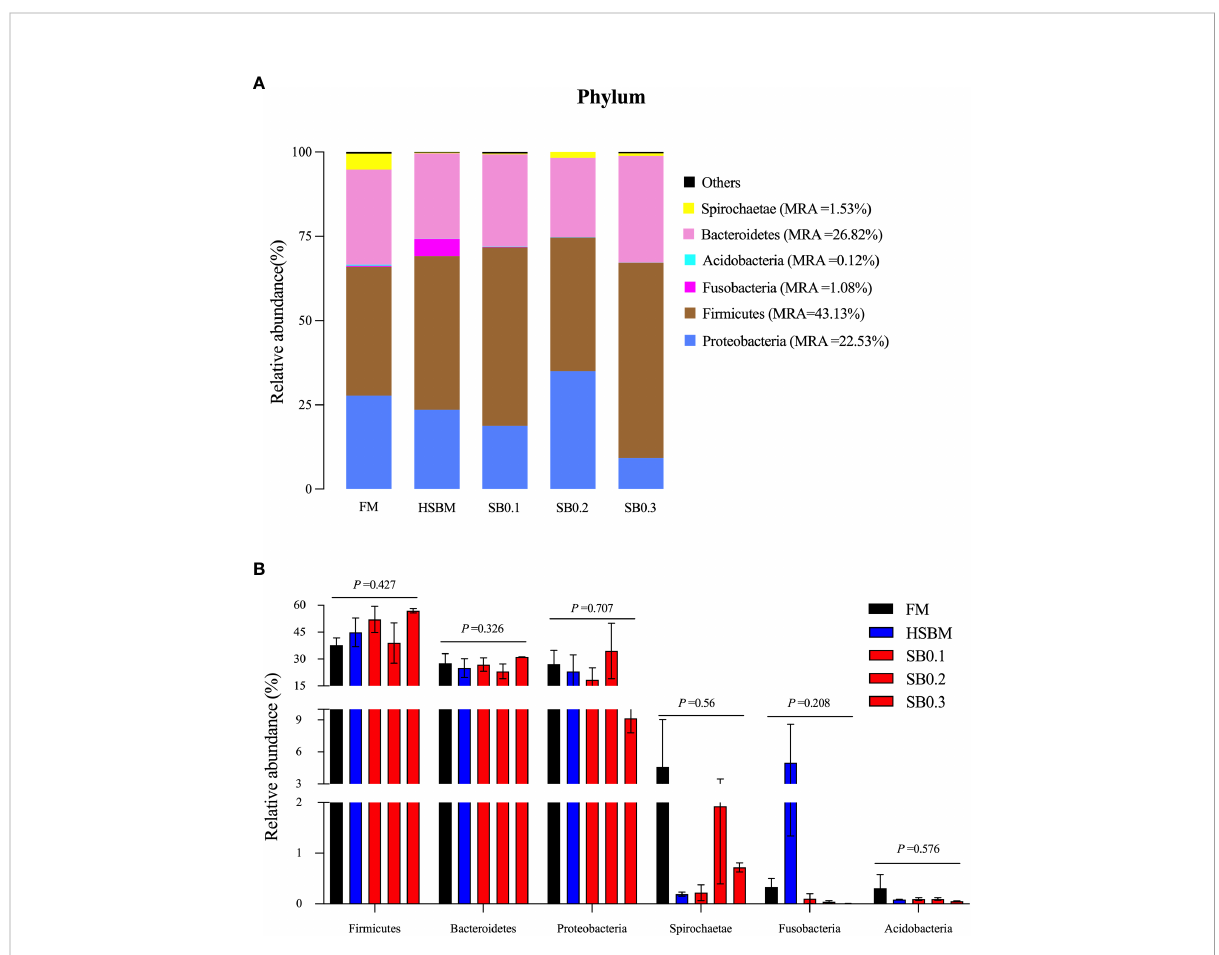
FIGURE 4 Relative abundance of the dominant bacterial phylum in different samples in the distal intestine of E. coioides (A) Intestine microbial composition at phylum level, (B) Differential analysis at phylum level. Bars bearing the different letters indicate signi fi cant differences ( P < 0.05), while that with the same letters indicate no signi fi cant difference ( P > 0.05). Data are presented as means ± SEM (n = 3 tanks). Statistical analysis was performed by one-way ANOVA, followed by S-N-K test. FM, fi sh meal; HSBM, 60% FM protein replacement with SBM in FM diets without SB addition; SB0.1, SB0.2 and SB0.3, 0.1%, 0.2%, and 0.3% SB were added in the HSBM diets, respectively. MRA, mean relative abundance.